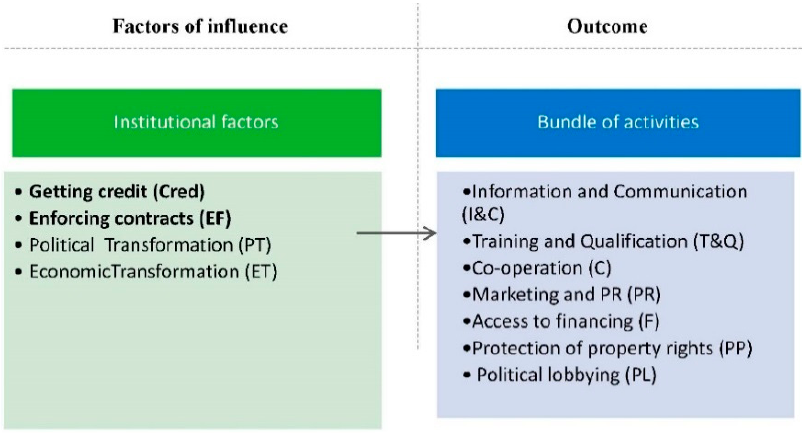
Figure 2. Research framework. Source: Authors´ development.